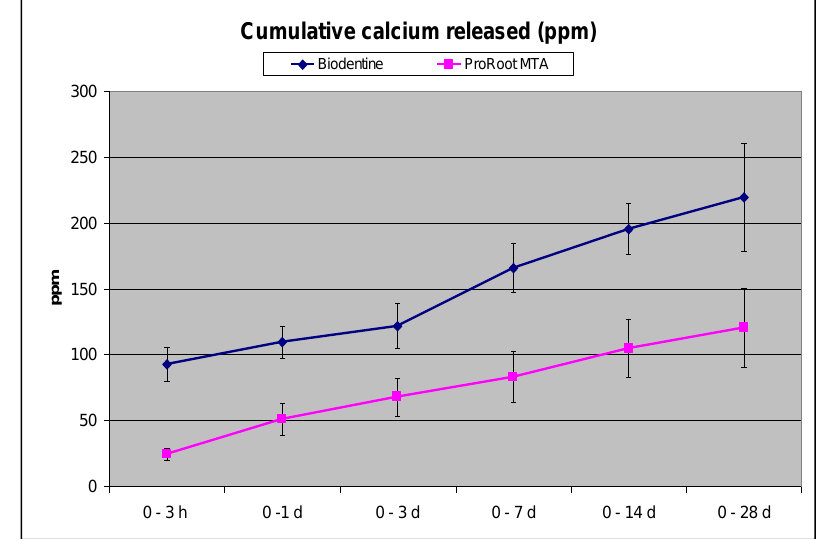
Figure 1. Cumulative calcium released in soaking